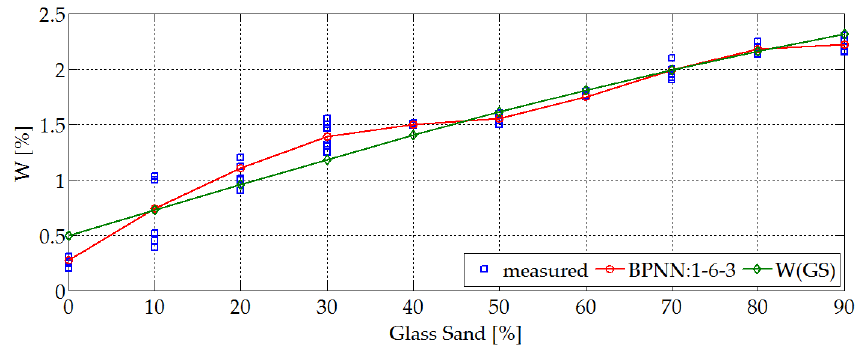
Figure 9 . Bulk density (γ) as a function of glass sand content